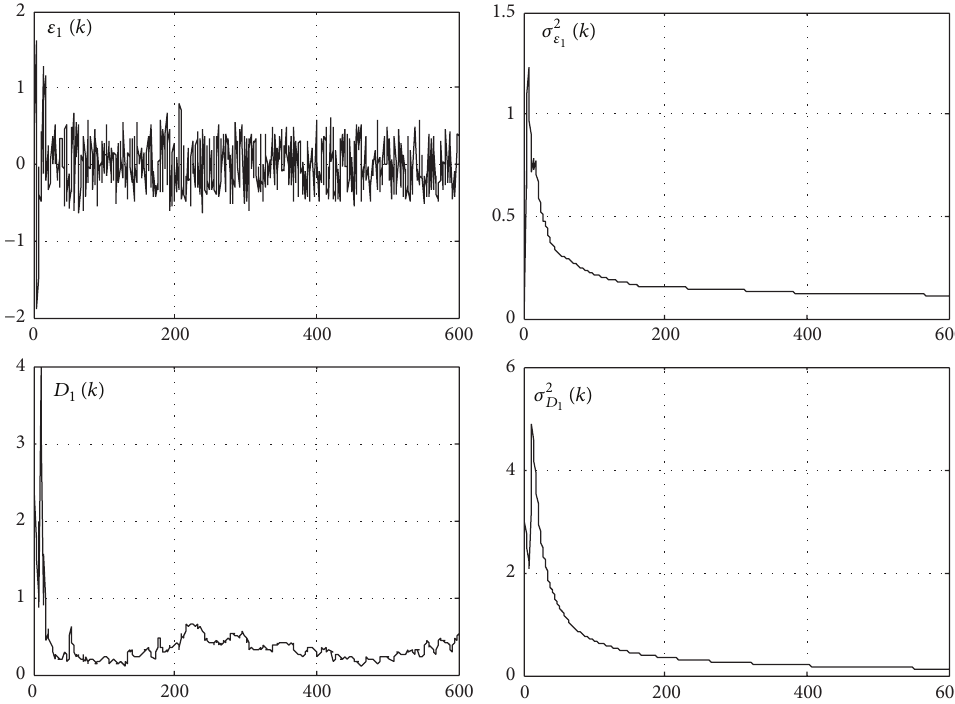
(𝑘) and 𝜎 2 (𝑘) . 𝐷 1 1